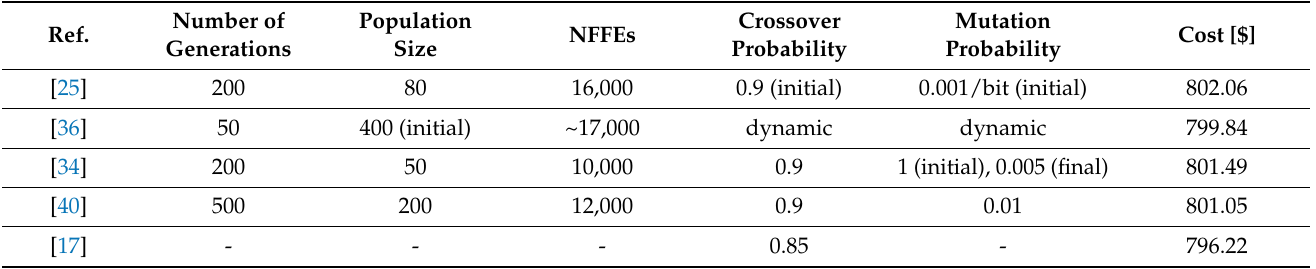
Table 5. Reported results of the reviewed GA OPF works for the IEEE 30-bus network and cost minimization objective